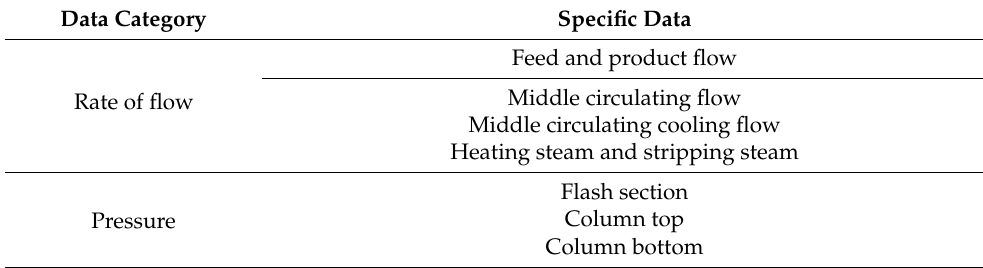
Table 1. Data requirements for VDU model.